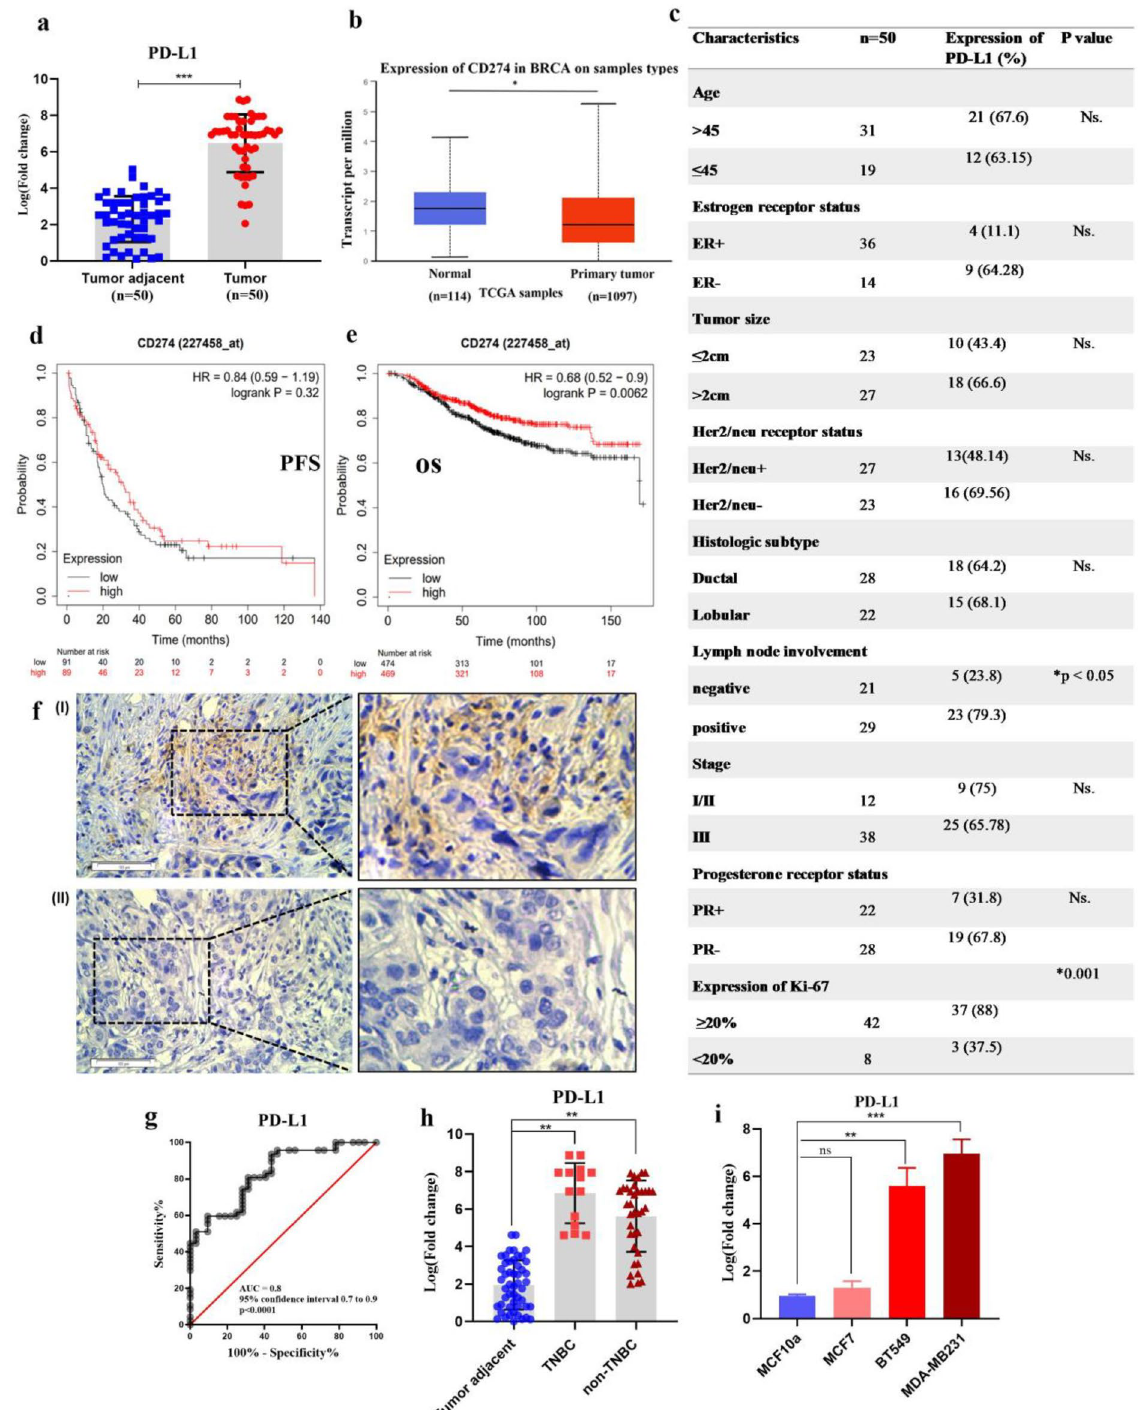
Figure 1. PD ‐ L1 expressions were analyzed in BC tissue samples and cell lines. ( a ) PD-L1 expression was upregulated in BC tissues (n = 50) as compared with normal samples using qRT ‐ PCR ( b ) Shows PD-L1 mRNA expression in normal and breast cancer tissues using TCGA database ( c ) The relationship between PD-L1 expression and clinical pathologic features ( d ) The Kaplan–Meier plotter shows the prognostic role of PD-L1 mRNA expression in progression-free survival ( e ) The Kaplan–Meier plotter for overall survival shows the prognostic role of PD-L1 mRNA expression in breast cancer ( f ) Immunohistochemical staining of PD-L1 (I) in breast cancer tissue and (II) in breast non-cancerous tissue ( g ) Area under the curve (AUC) and receiver operating characteristics (ROC) for PD-L1 ( h ) The correlation between PD-L1 expression with TNBC and non- TNBC status of the tumor ( i ) PDL1 expression in BC cell lines compared to normal breast cell line; ***P ≤ 0.001; **P ≤ 0.01; ns = non-significant. The results were expressed as the mean ± SE of the experiments. PD ‐ L1, programmed death-ligand 1; qRT ‐ PCR, quantitative reverse transcription-PCR; TP, Tumor Patient; NTP, Non- Tumor